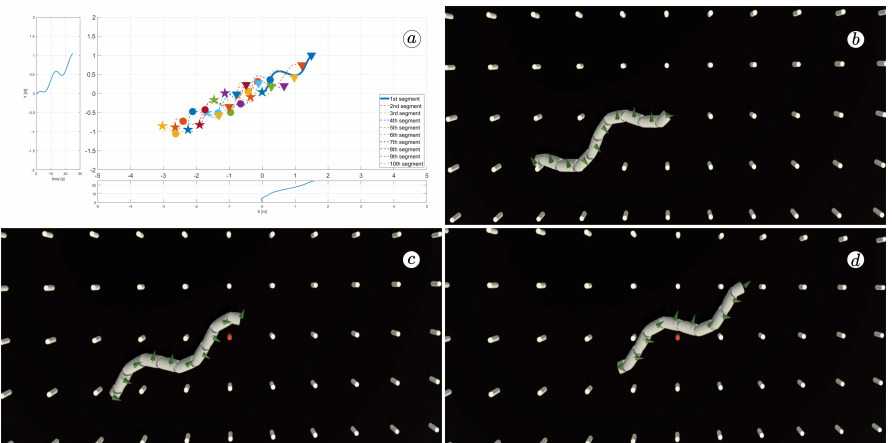
Figure 28. Trajectories of robot segments for φ i ,ref = 50 ◦ sin ( 30 ◦ t + ( i − 1 ) 60 ◦ ) ( a ) and robot configu- rations for t = 5 ( s ) ( b ), t = 10 ( s ) ( c ), and t = 24 ( s ) ( d ).